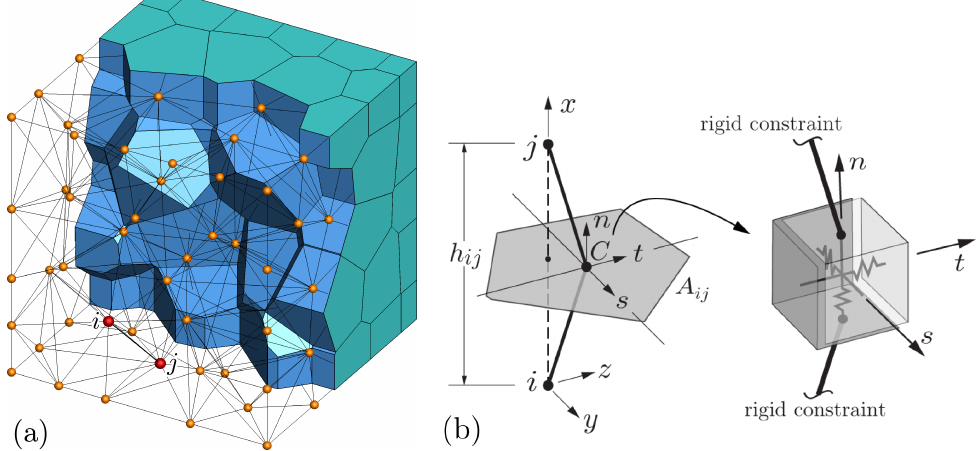
Figure 1. Lattice model: ( a ) domain discretization based on Delaunay and Voronoi tessellations; ( b ) lattice element i − j